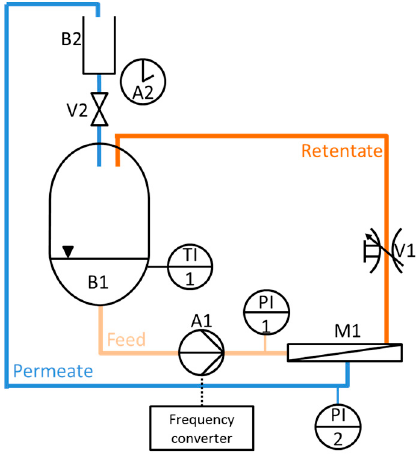
Figure 13. Cross-flow simulation permeance measurement device.